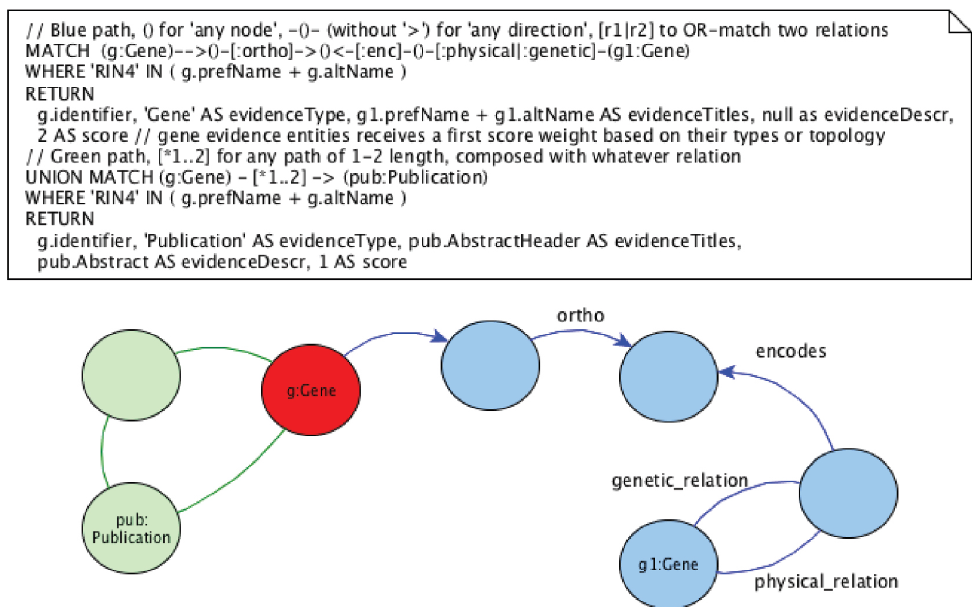
Figure 3: Using Cypher to query genome-scale knowledge networks. The query corresponds to the graph pattern on the